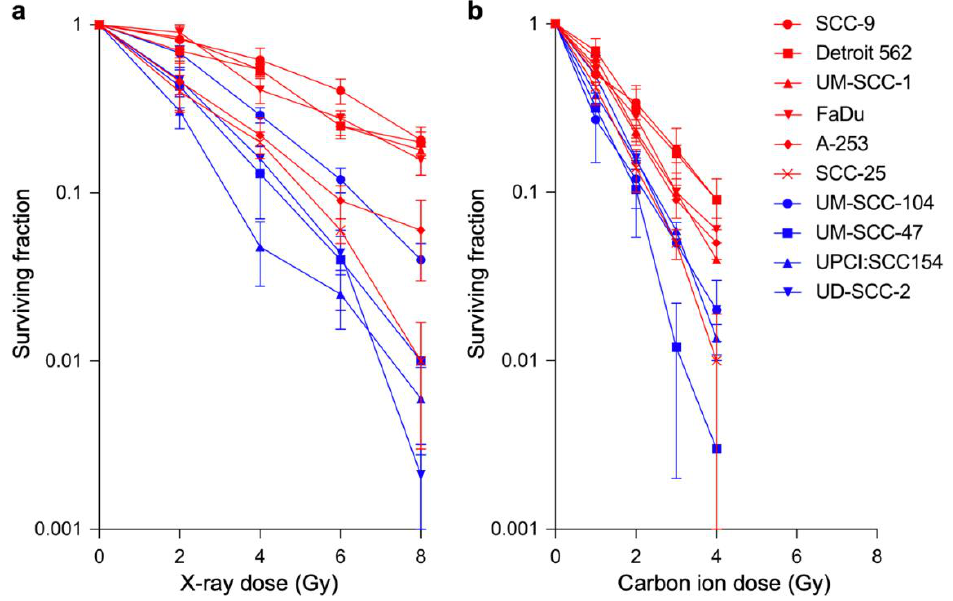
Figure 1. Clonogenic survival of head-and-neck squamous cell carcinoma cell lines treated with X-rays ( a ) or carbon ions ( b ). Human papillomavirus-positive or -negative cell lines are indicated in blue and red, respectively.